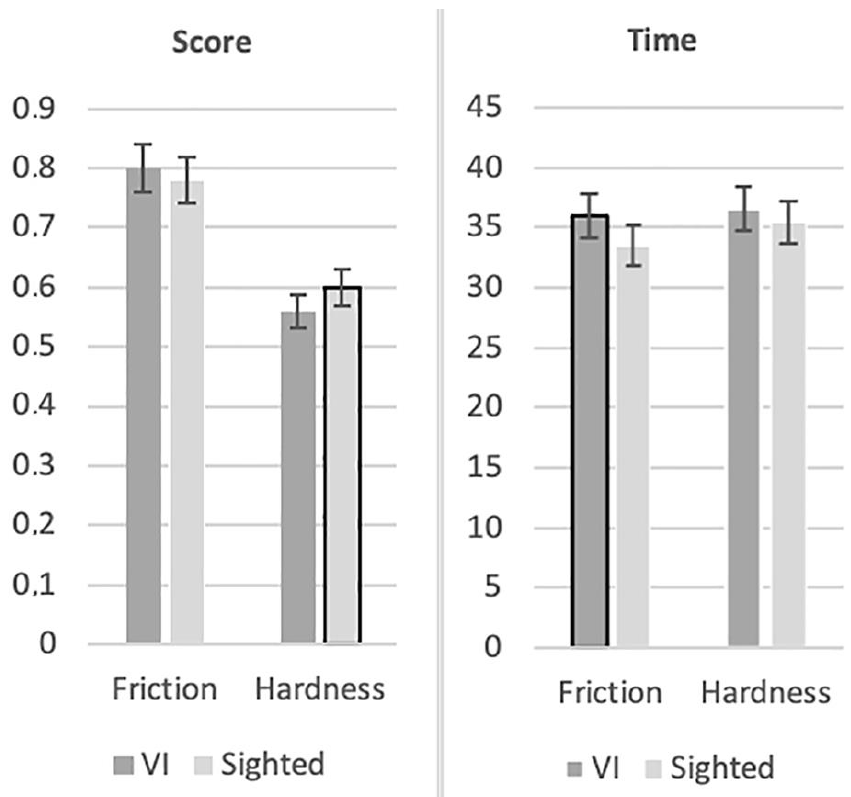
Figure 3. Participants’ scores (participants with VI and sighted participants) and their completion time (seconds) in each test. The significant differences are highlighted with a black border.